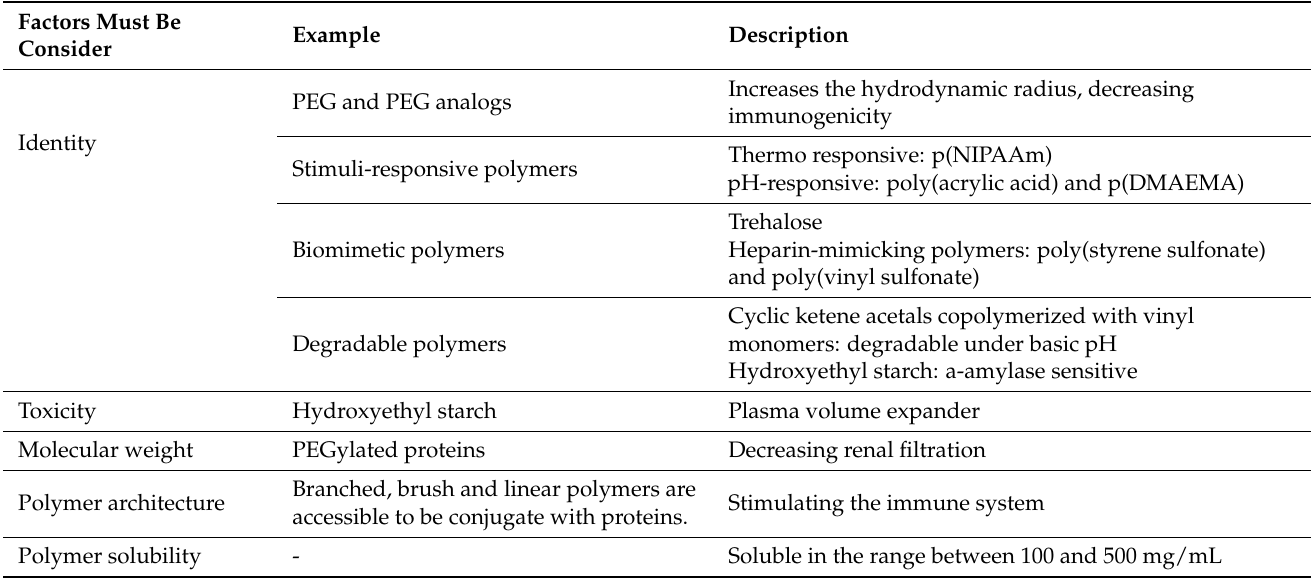
Table 2. Essential considerations in selecting a suitable polymer for protein-polymer conjugation [143].